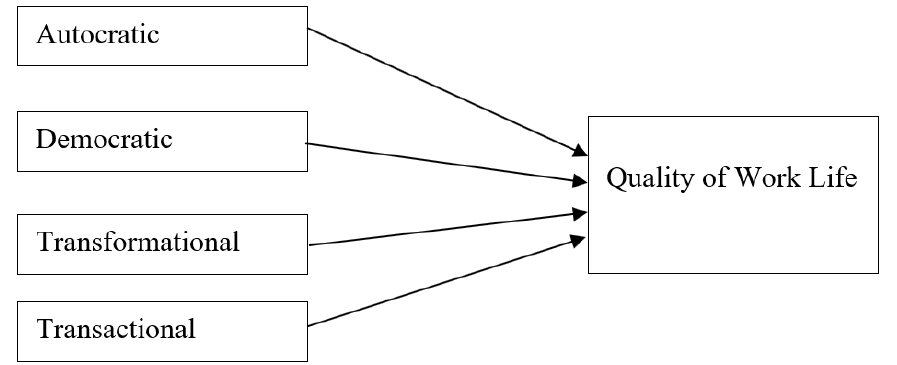
Figure 1. Proposed